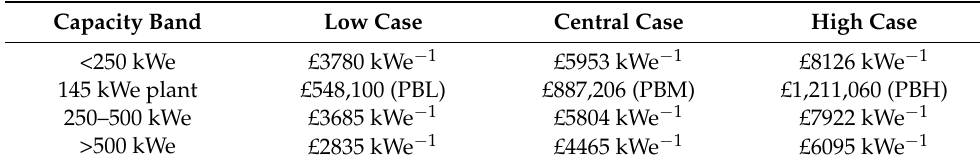
Table 5. Literature-based data indicating capital costs for a range of digester sizes (derived from figures available in [68]) and, thus, calculated capital cost for a 145 kWe plant (PBL: Parsons Brincker- hoff Low Case figure; PBM: Parsons Brinckerhoff Central Case (i.e., median) figure; PBH: Parsons Brinckerhoff High Case figure).